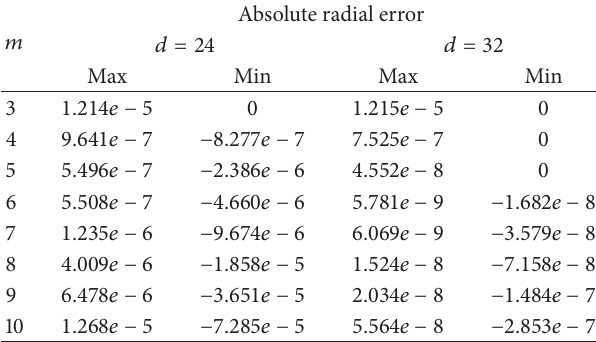
Figure 5: Number of correct bits of result as a function of 𝑚 at 𝑅 = 2 2𝑚+3 and 𝑑 = 24 . Table 3: Maximum values of the absolute radial error ( 𝑅 = 2 𝑚 ) for proposed Algorithm (26).